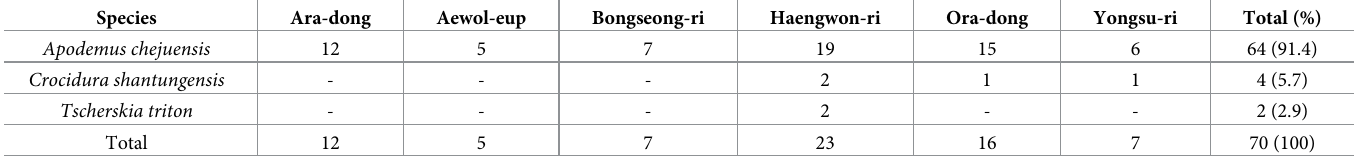
sequence of HTNV was obtained from the lung tissues of A . chejuensis captured on Jeju Island. Table 1. Trapping results of small mammals collected at sites on Jeju Island in the Republic of Korea, 2018–2020. Species Ara-dong Aewol-eup Bongseong-ri Haengwon-ri Ora-dong Yongsu-ri Total (%) Apodemus chejuensis 12 - - Tscherskia triton